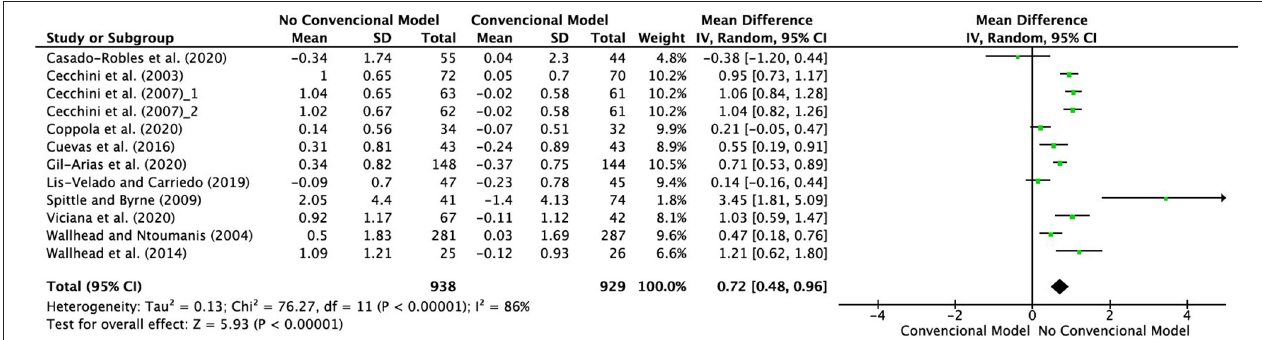
FIGURE 2 | Results of the meta-analysis of the effects of interventions on fun in sport